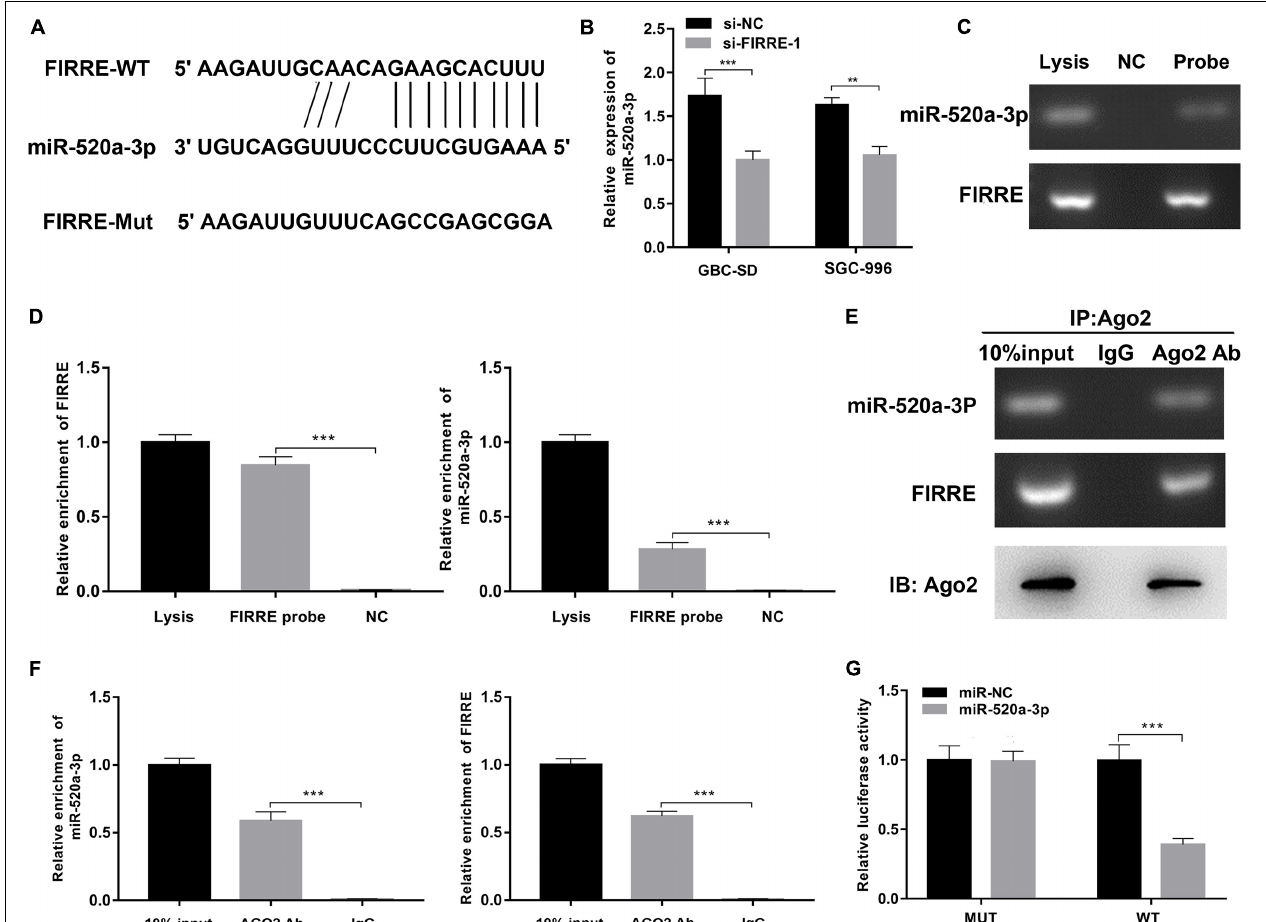
FIGURE 4 | FIRRE functions as a sponge for miR-520a-3p. (A) The miR-520a-3p binding site on FIRRE predicted by miRanda and RNAhybrid. (B) The relative expression of miR-520a-3p was detected by qRT-PCR after transfection with si-FIRRE-1 in GBC-SD cells and SGC-996 cells. (C,D) RNA pull-down was executed in GBC-SD cells, followed by qRT-PCR to detect the enrichment of FIRRE and miR-520a-3p. (E,F) Anti-AGO2 RIP was executed in GBC-SD cells after transfection with miR-NC and miR-520a-3p mimic, followed by western blot and qRT-PCR to detect AGO2 protein, FIRRE, and miR-520a-3p, respectively. (G) The relative luciferase activities were detected in 293 T cells after transfection with FIRRE-WT or FIRRE-Mut and miR-NC and miR-520a-3p mimic, respectively. ** p < 0.01, *** p < 0.001.